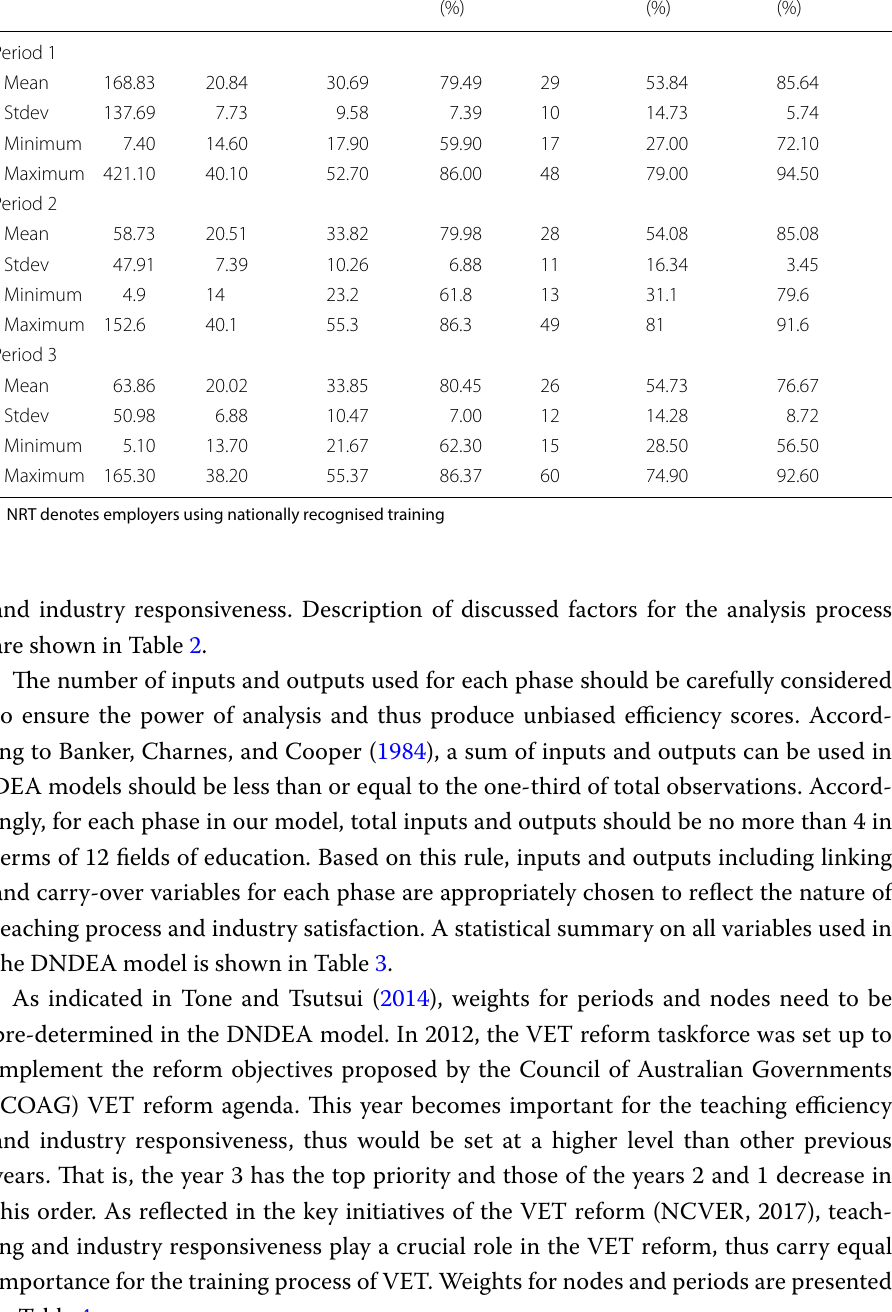
Table 3 Summary statistics of inputs and outputs